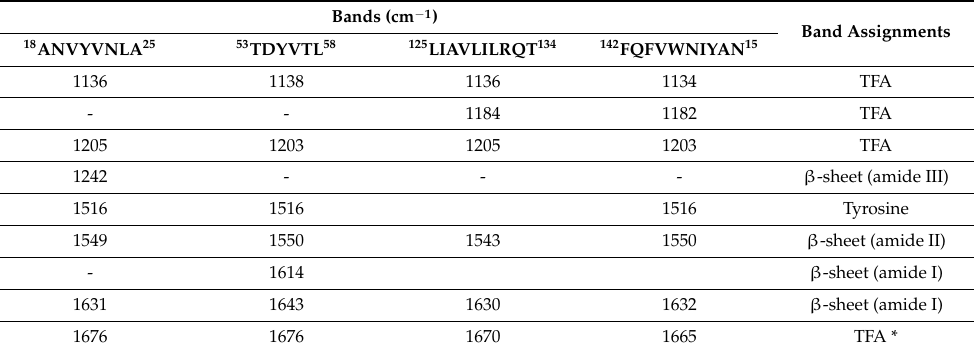
Table 1. Bands observed in the ATR FT-IR spectra obtained from thin hydrated films produced by 18 ANVYVNLA 25 , 53 TDYVTL 58 , 125 LIAVLILRQT 134 and 142 FQFVWNIYAN 151 solutions, respectively, and their relative